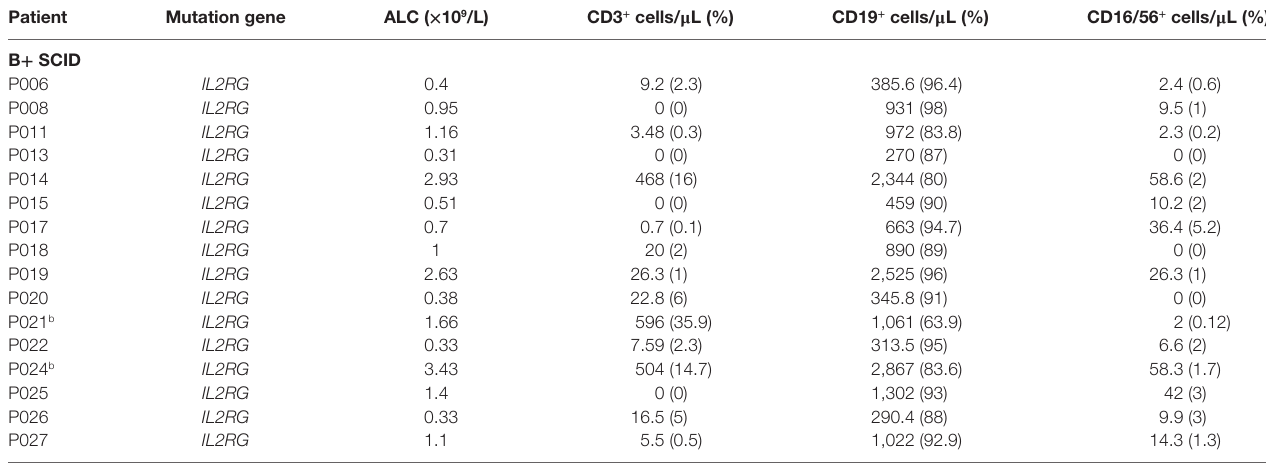
TaBle 3 | Lymphocyte subset for patients included in our study ( n =